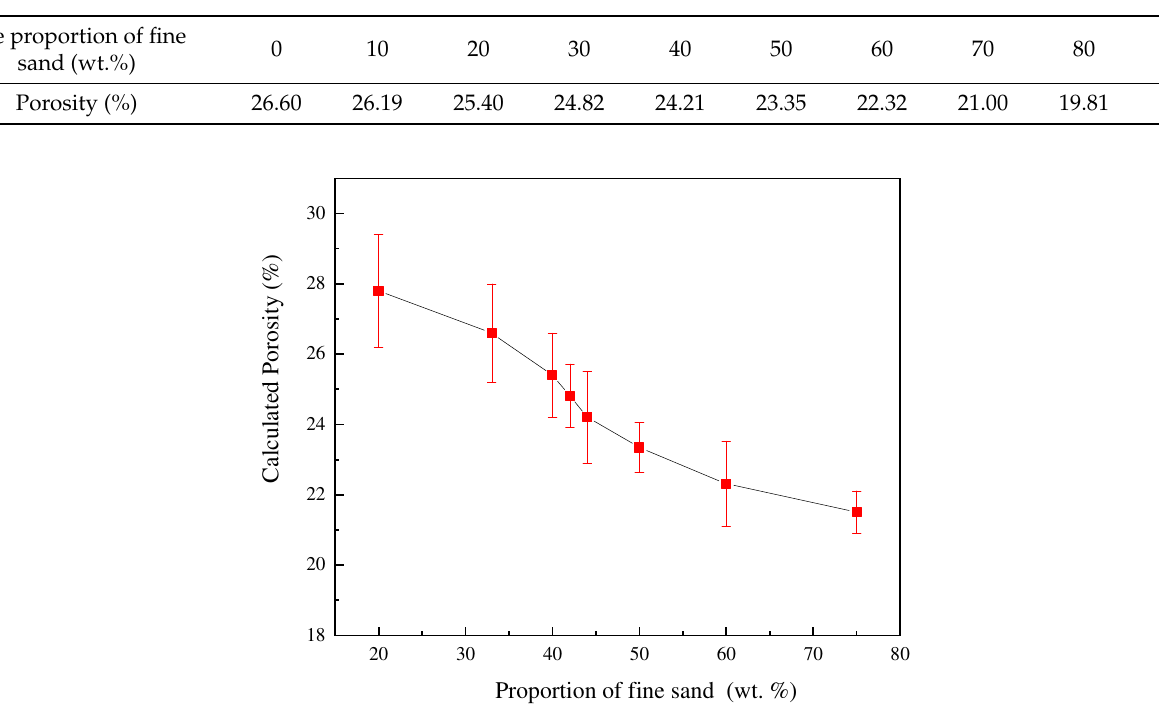
Figure 8. Effect of different fine sand proportions on calculated porosity.